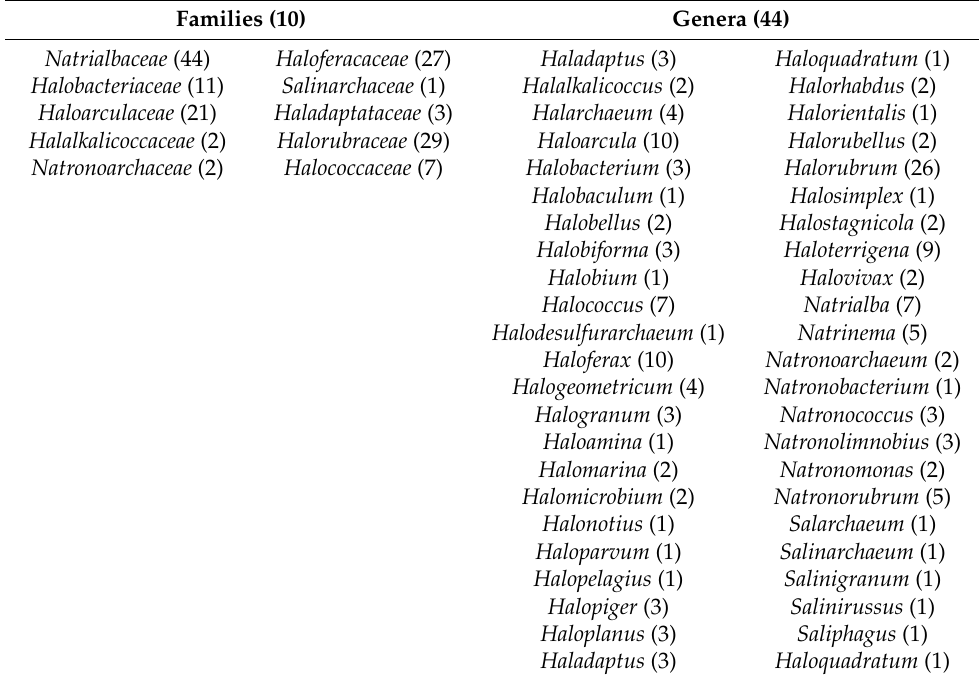
Table 2. Classification of the species selected for this study by genera and family. In brackets the number of species that belong to that specific taxonomic level is